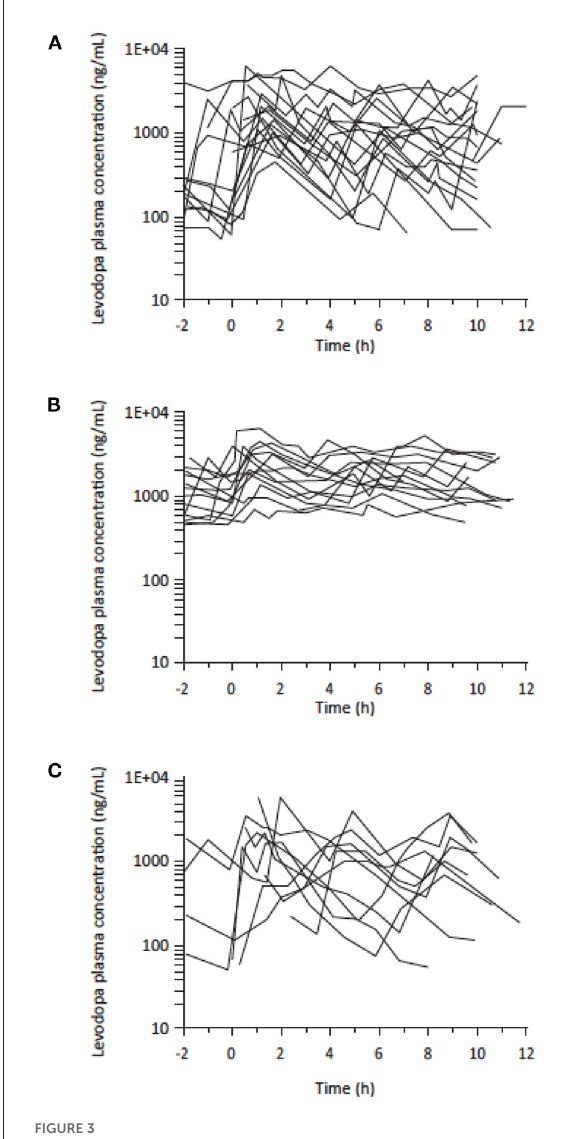
FIGURE3 Levodopa plasma levels (logarithmic scale) in patients with PD experiencing motor fluctuations treated with (A) standard of care (SoC) levodopa ( N = 30) (B) SoC levodopa plus ND0612 infusion ( N = 19)* (C) SoC levodopa plus placebo infusion ( N = 11)*. *Standard of care levodopa plus ND0612 (60/14 mg/ml) or placebo infused at a rate of 0.08 ml/h over 8h and 0.24 ml/h over